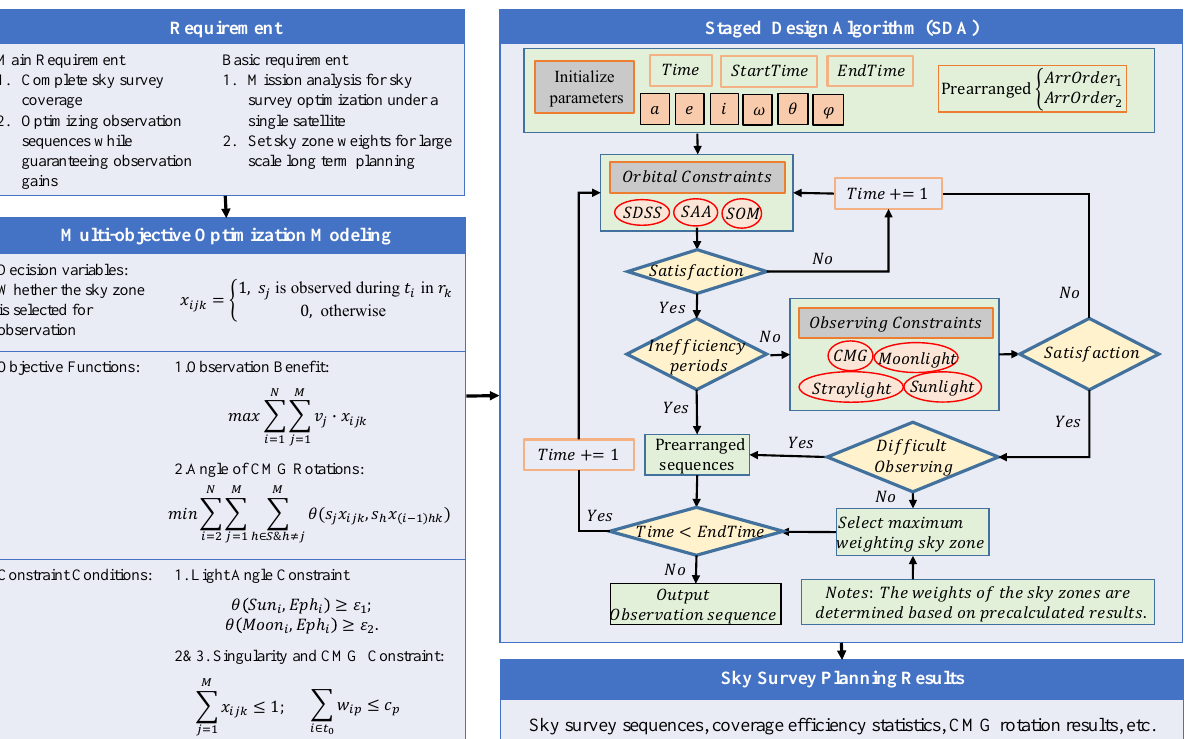
Sky survey sequences, coverage efficiency statistics, CMG rotation results, etc. Figure 2. The flow chart of the wide and deep sky survey observation mission in this